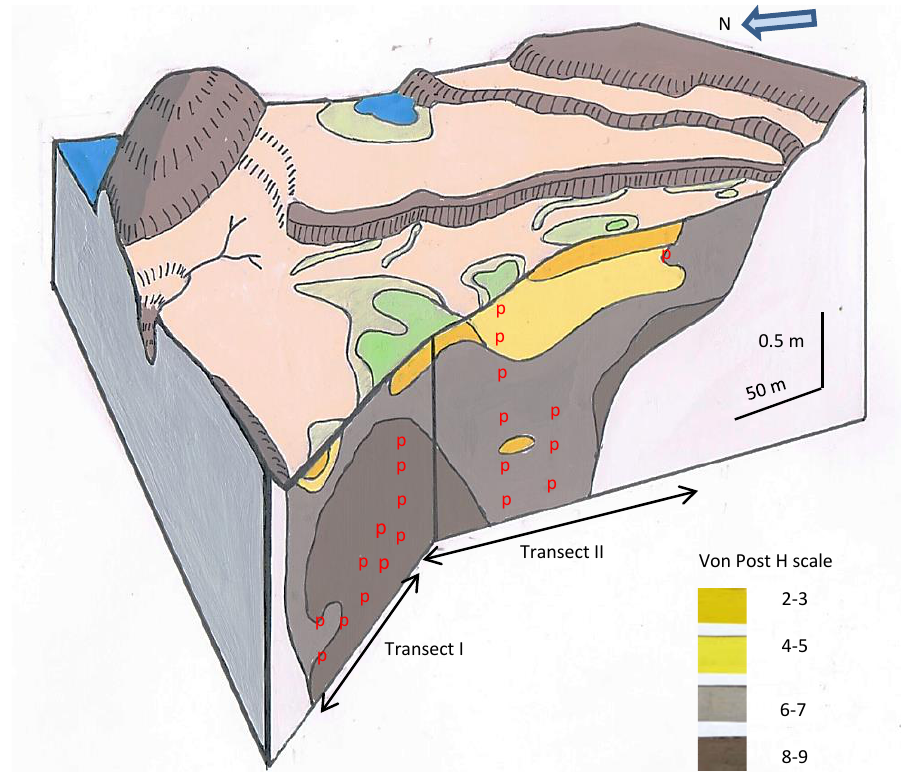
Figure 5. Degree of decomposition of peat profiles on Transects I and II according to the von Post humification (H) scale. Well-preserved peat is present only in the upper layers. P = remains of Phragmites australis .